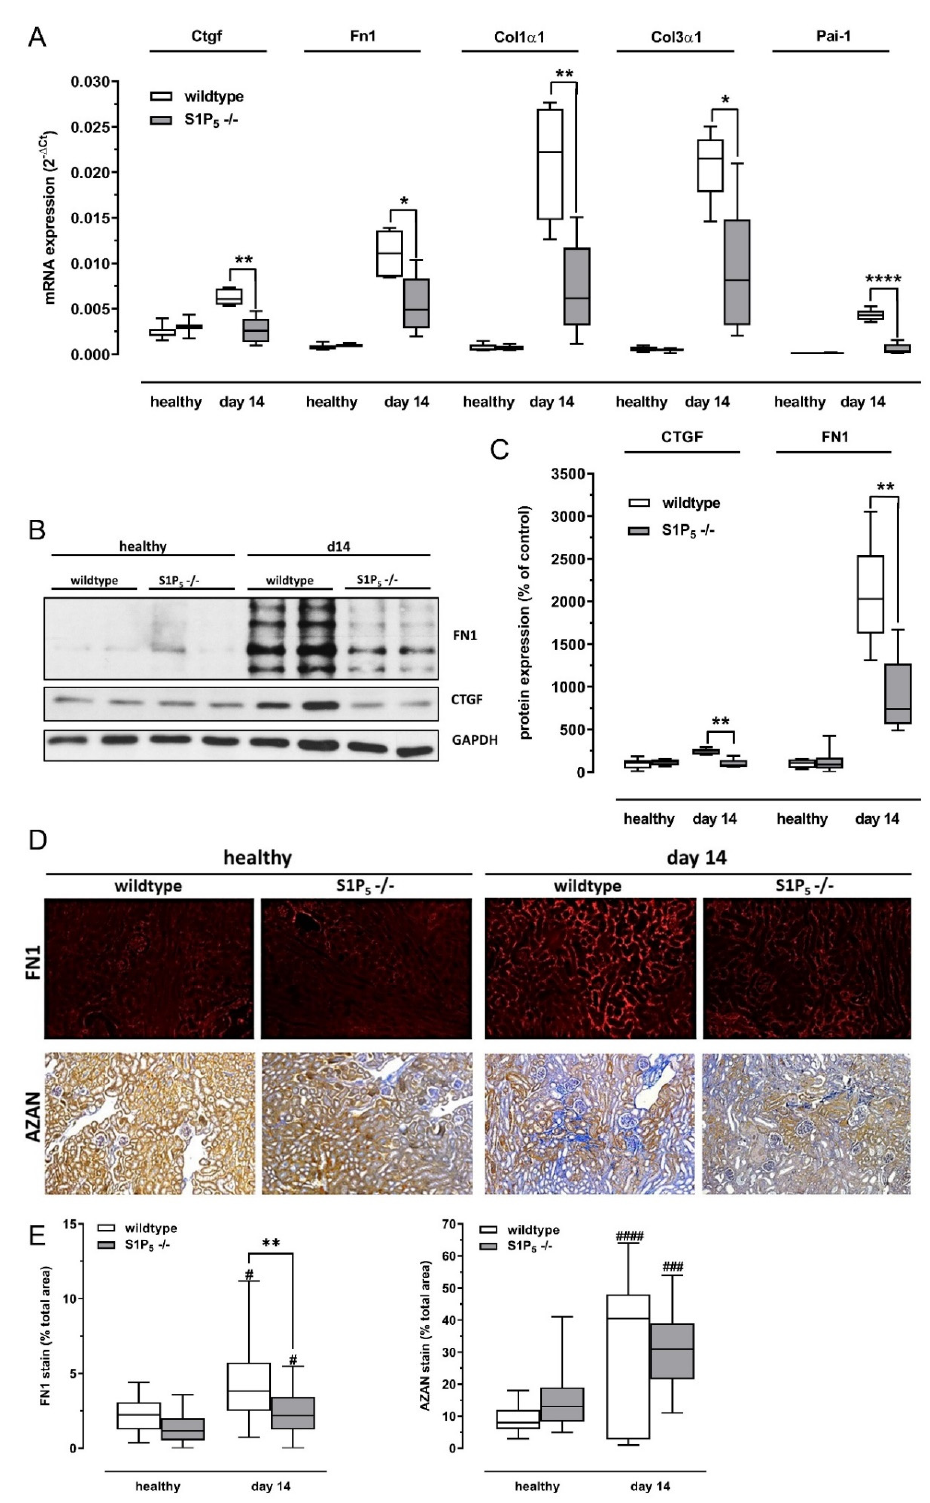
Figure 6. Gene expression and staining of fibrotic markers. ( A ) Expression levels of CTGF, Fn1, Pai-1, and Acta-2/ α SMA mRNA were determined by TaqMan ® analysis as described in Materials and Methods. The levels were compared between wild-type (C57BL/6J) and S1P 5 knockout mice (S1P 5 -/- ) without (healthy) and with an adenine-rich diet for 14 days (d14). The internal standard used was 18 s ribosomal RNA. ( B , C ) Representative Western blot ( B ) and quantification results from all Western blots ( C ) of fibronectin 1 (Fn1) and connective tissue growth factor (CTGF) from whole kidney